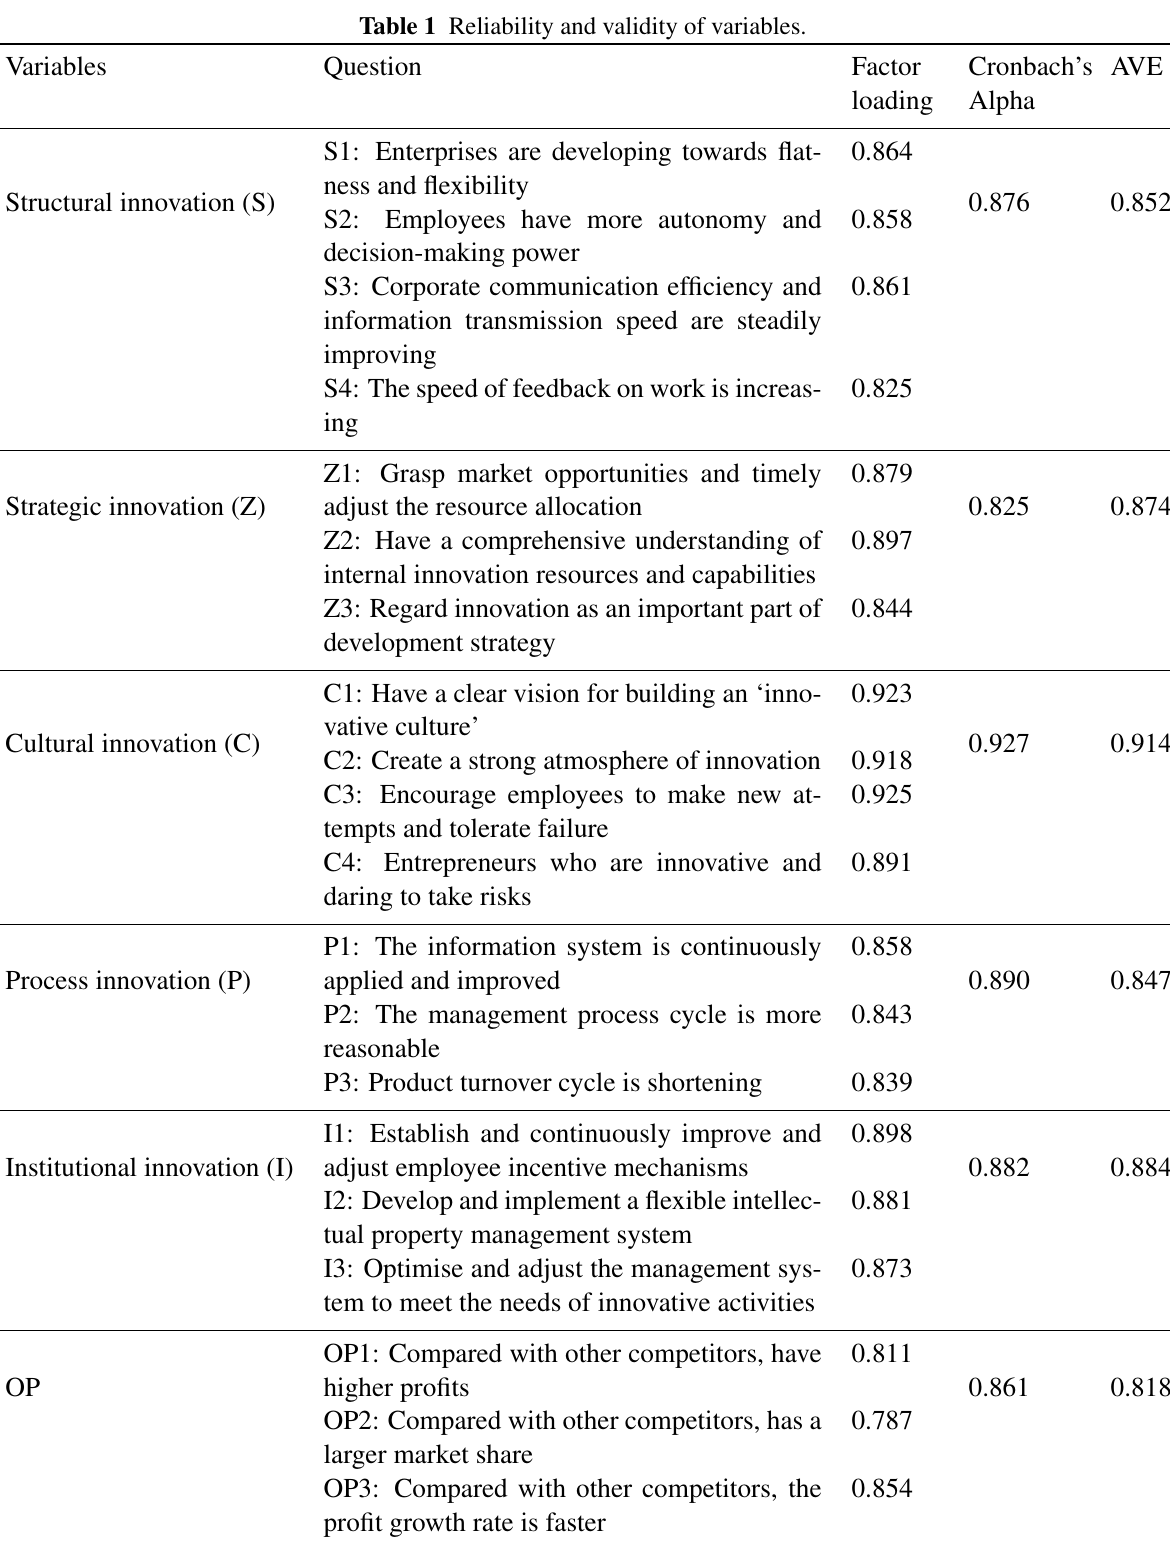
Table 1 Reliability and validity of